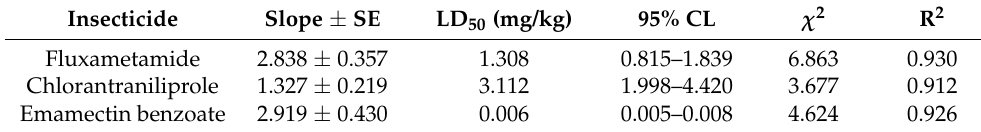
Table 1. Lethal effect of insecticide on fourth-instar larvae of C. suppressalis after 72 h treatment. Insecticide Slope ± SE LD 50 (mg/kg)